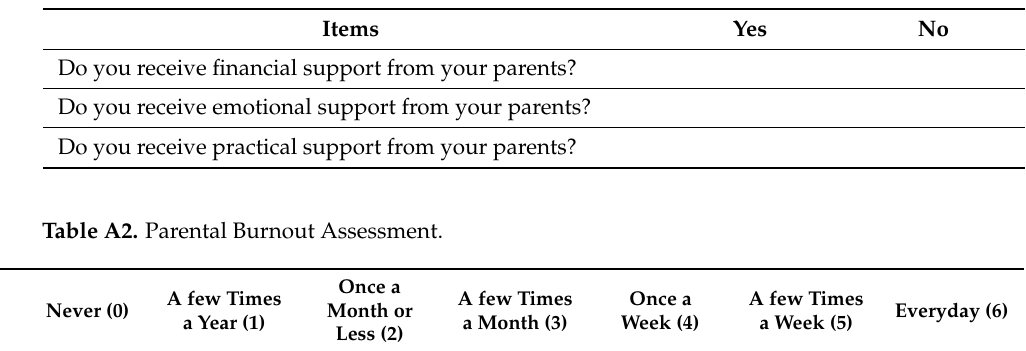
Table A1. Intergenerational Support Scale.